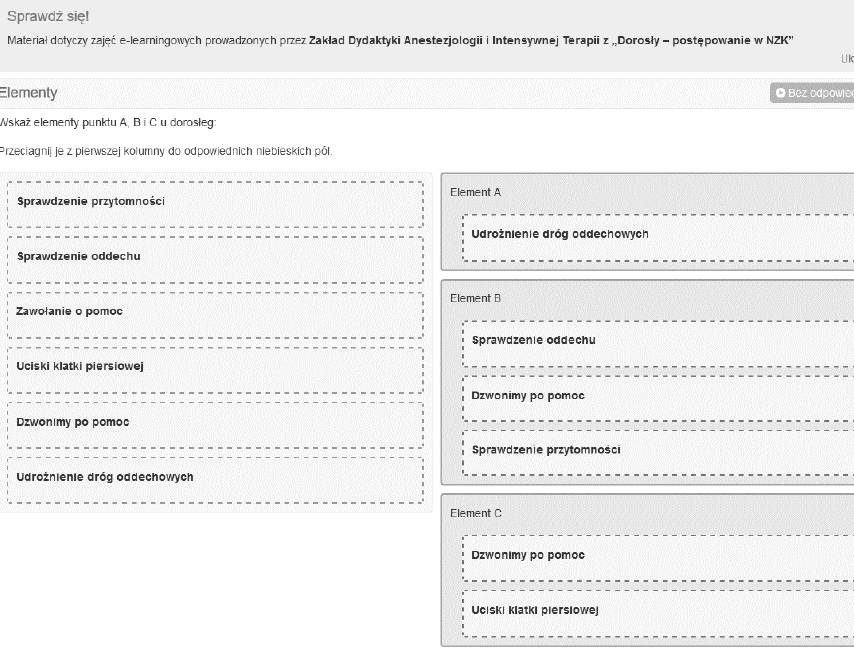
Figure 9. E-learning course in First Aid for year 1 students of Medicine. Example practical tasks in an e-learning course